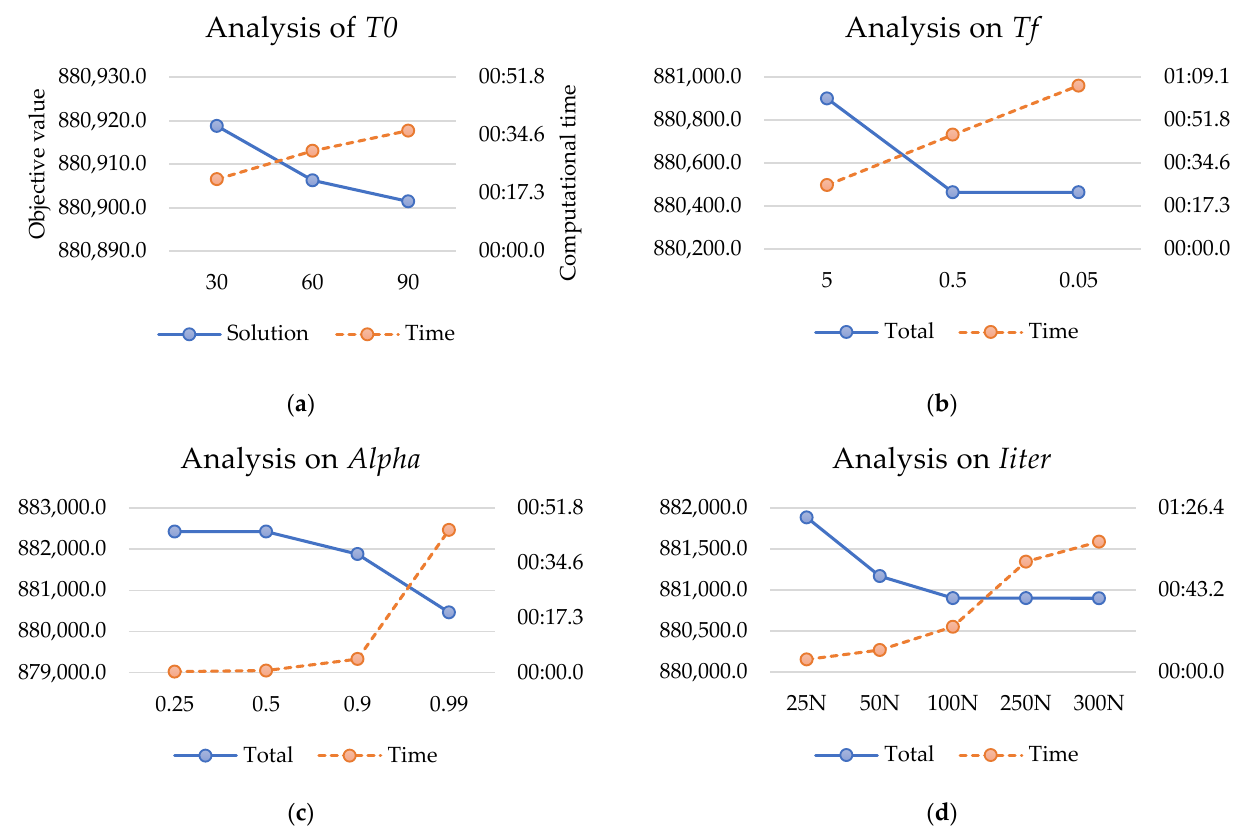
Figure 4. Analysis of the impact of parameters T0 ( a ), Tf ( b ), Alpha ( c ), and Iiter ( d ) on objective value and computational time.